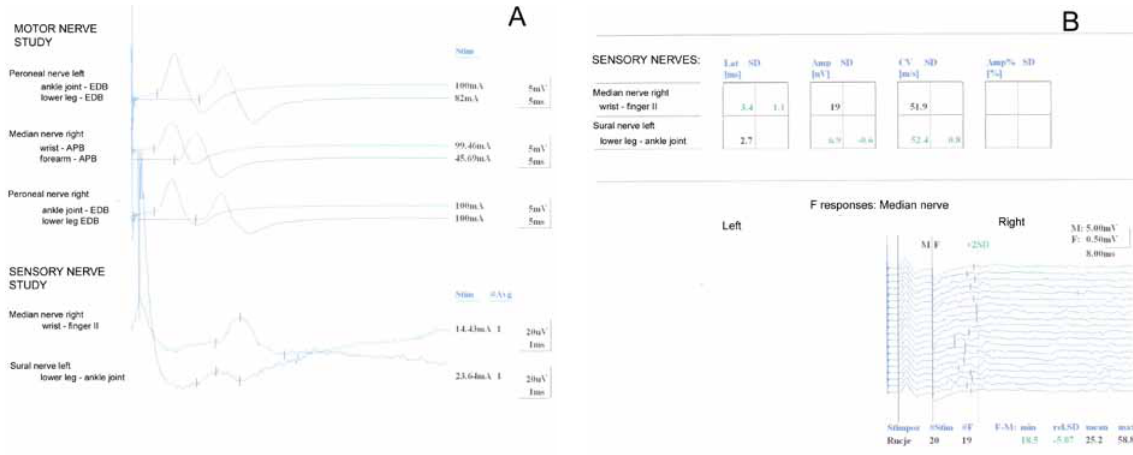
Figure 3. Electromyoneurography (EMNG): typical finding of polymyositis with stronger affected proximal muscles of the lower extremities, without any sign of disturbances of innervation (Panels A and